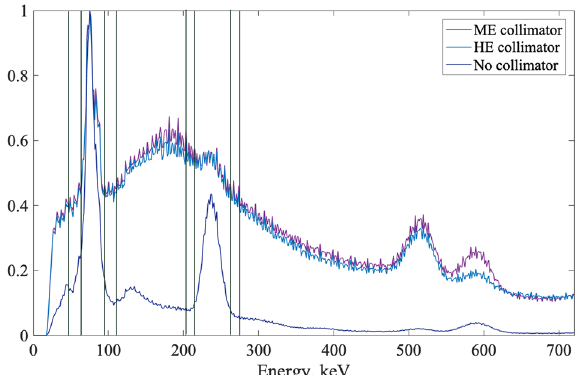
Fig. 2 Energy spectra acquired on the SPECT scanner with a 212 Pb source. The two investigated energy windows and their adjacent scatter windows are also illustrated. The spectrum with the ME collimator is shown in purple, the spectrum with the HE collimator is shown in light blue, and the spectrum acquired without a collimator is shown in dark